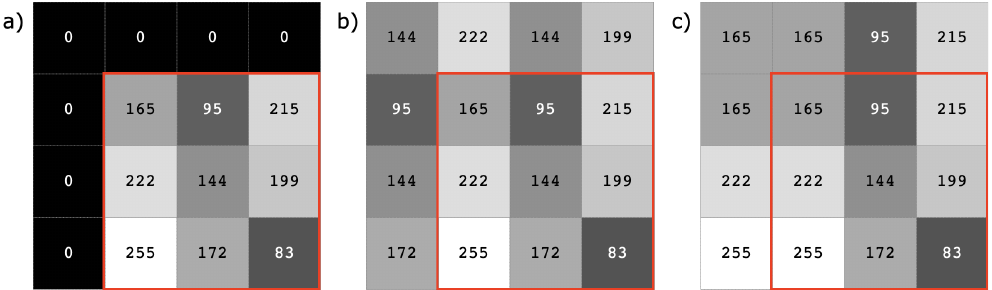
Figure 4. Variations of the paddings around the border used in the convolutional layer of the CNN: ( a ) zero padding, ( b ) reflection padding, and ( c ) replication padding. The red box shows the boundary at the top left-hand corner of an image, and the numbers in each pixel represent the pixel